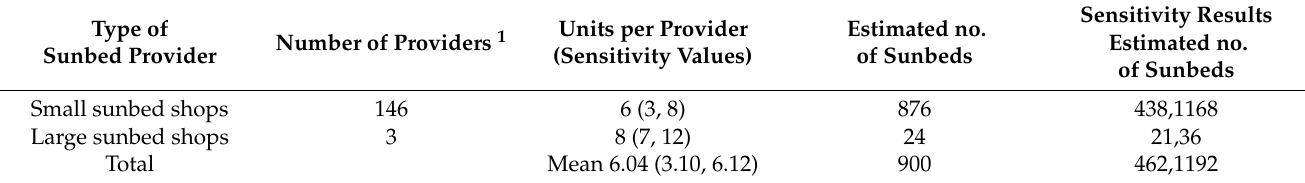
Table 2. Estimated number of providers of commercial sunbeds and units in Greater Manchester.